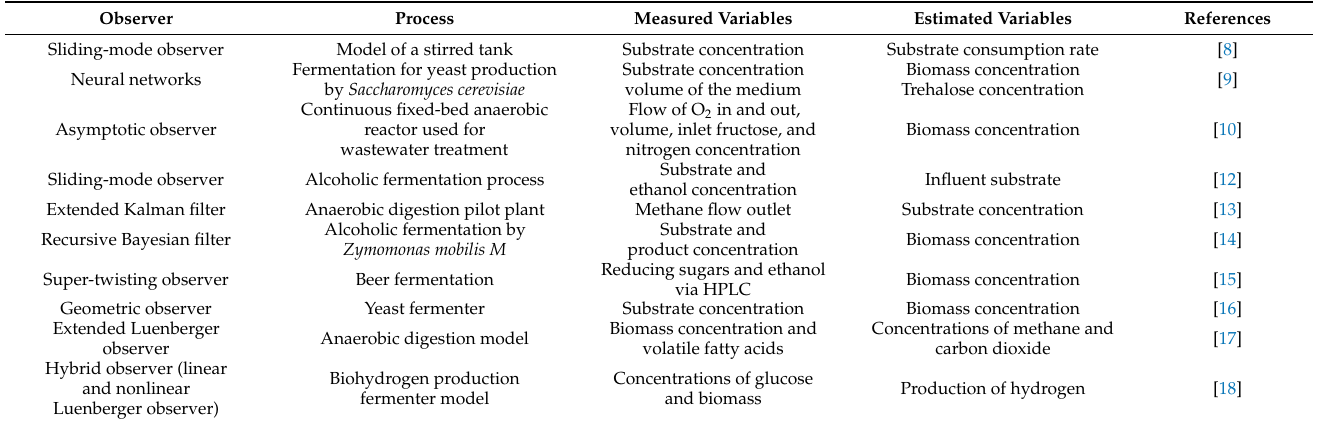
Table 1. Overview of the application of state observers in